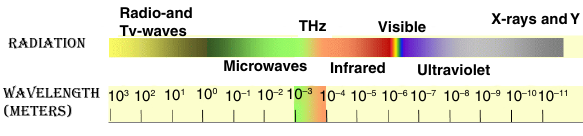
Figure 1. The THz spectrum. It can be seen that THz radiation is the gap between the infrared and microwaves.